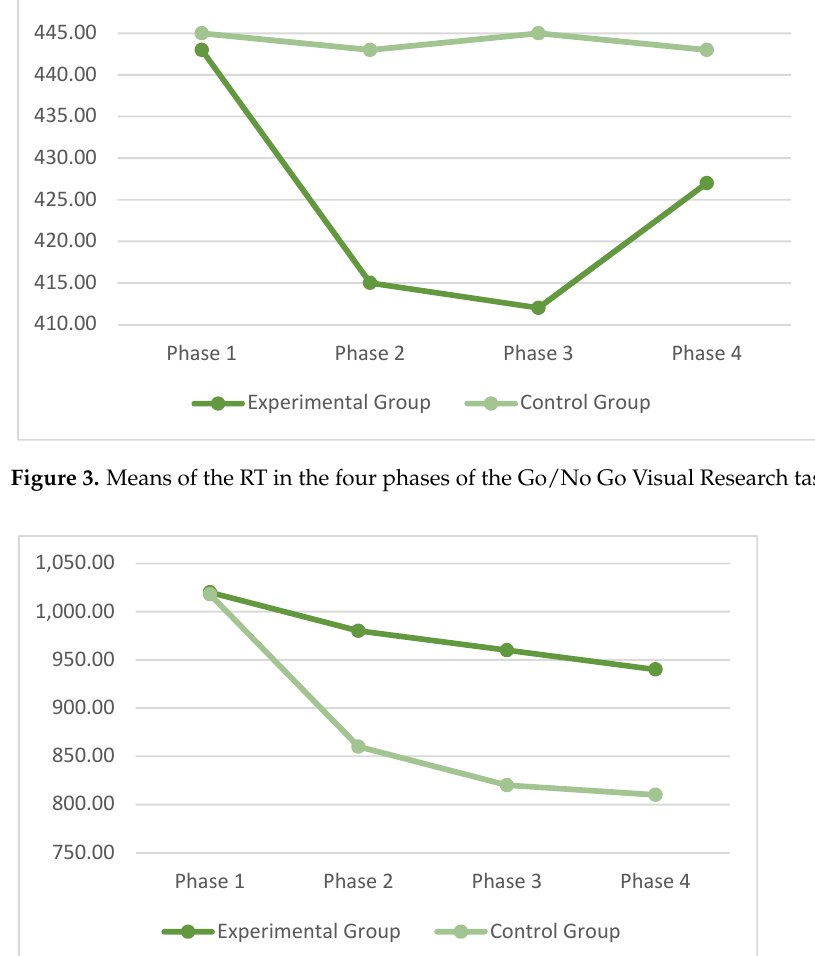
Figure 4. Means of the RT in the four phases of the N-Back task.